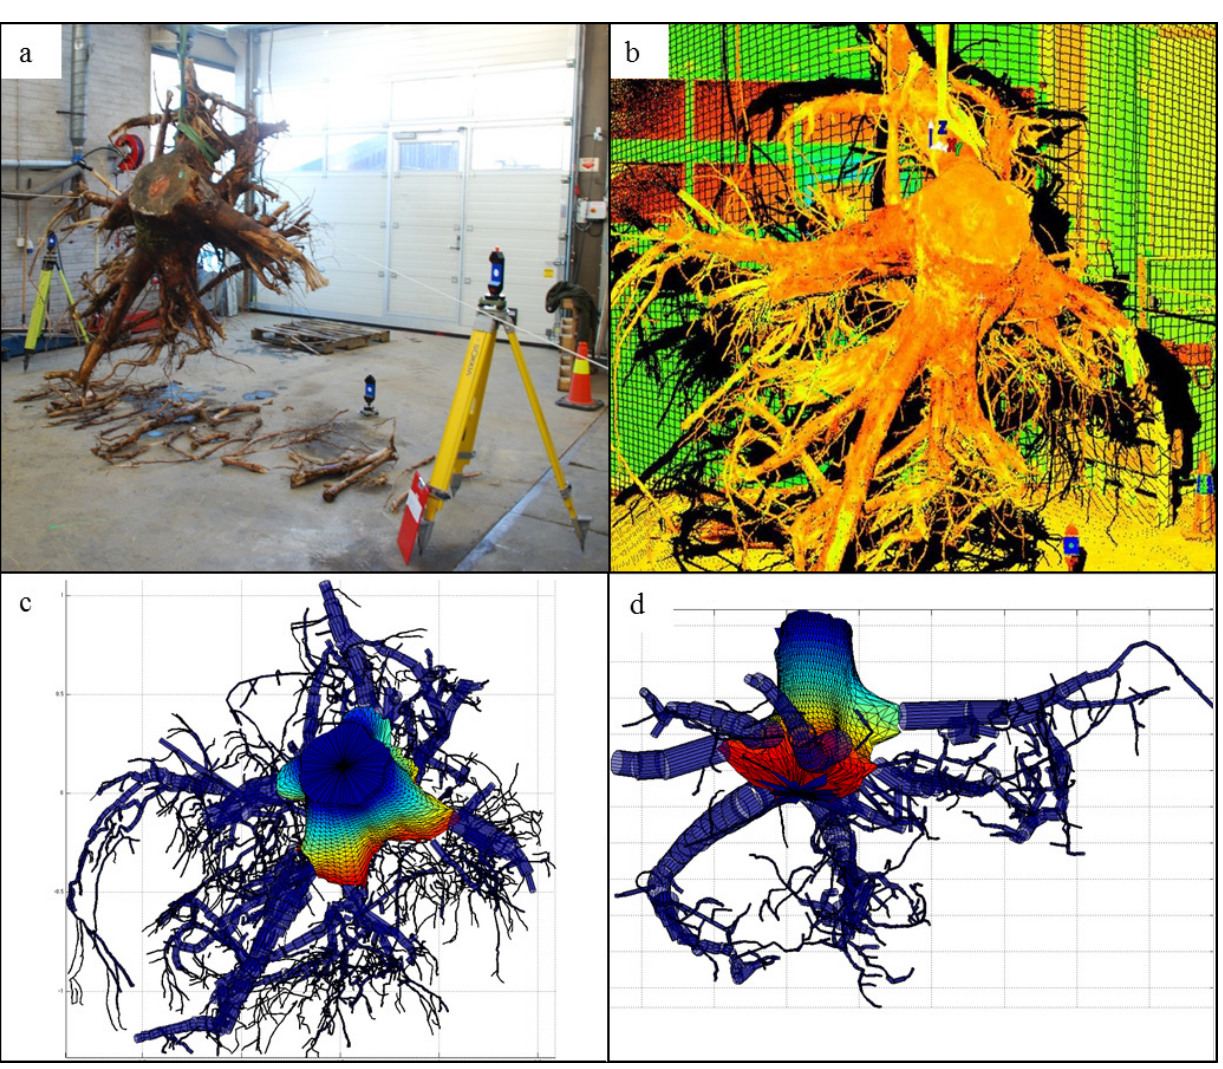
Figure 2. Root system images: ( a ) Root system 3 suspended at scanning; ( b ) A 2D reprojection of the TLS point cloud data of root system 3, showing the effects of sensor obscuration (black shadow); ( c ) Top view of the QSM of root system 3; ( d ) Oblique bottom view of the QSM of root system